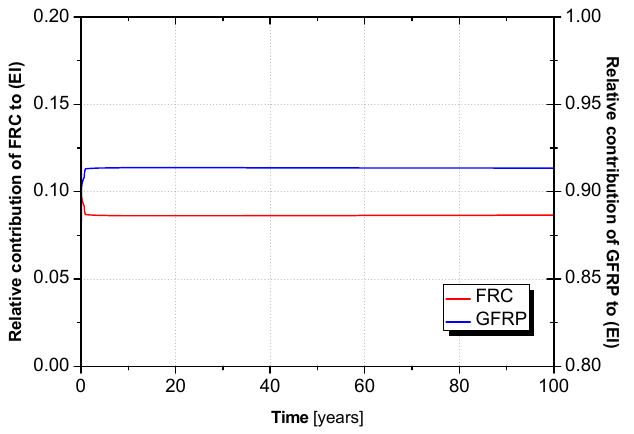
Figure 19. Time-dependent relative contributions of the GFRP faces ( α GFRP ) and FRC ( α FRC ) layer to the panel’s flexural stiffness ( EI